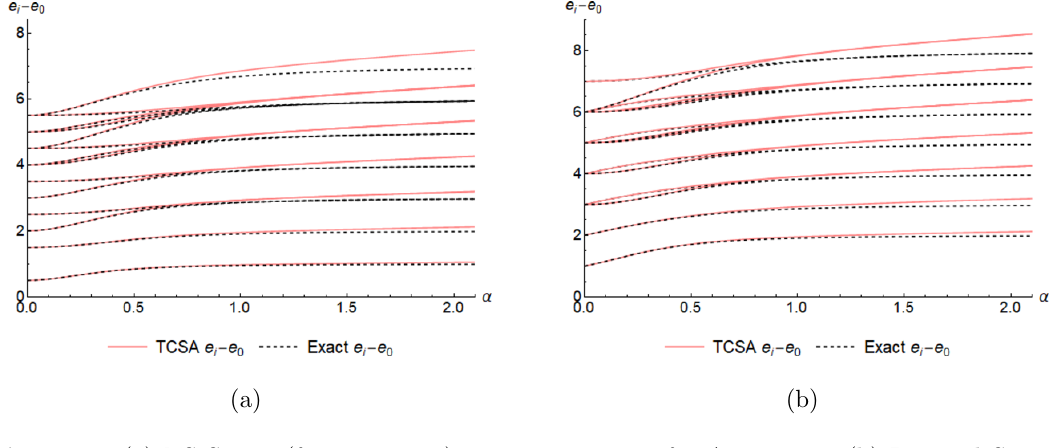
Figure 2. (a) NS Sector (free spectator). e i (cid:0) e 0 versus (cid:11) for (cid:1) max = 38; (b) Ramond Sector ((cid:12)xed spectator). e i (cid:0) e 0 versus (cid:11) for (cid:1) max =